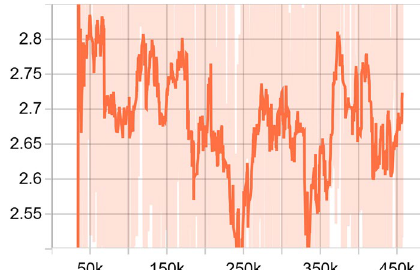
Fig. 4 Tensor-board test loss